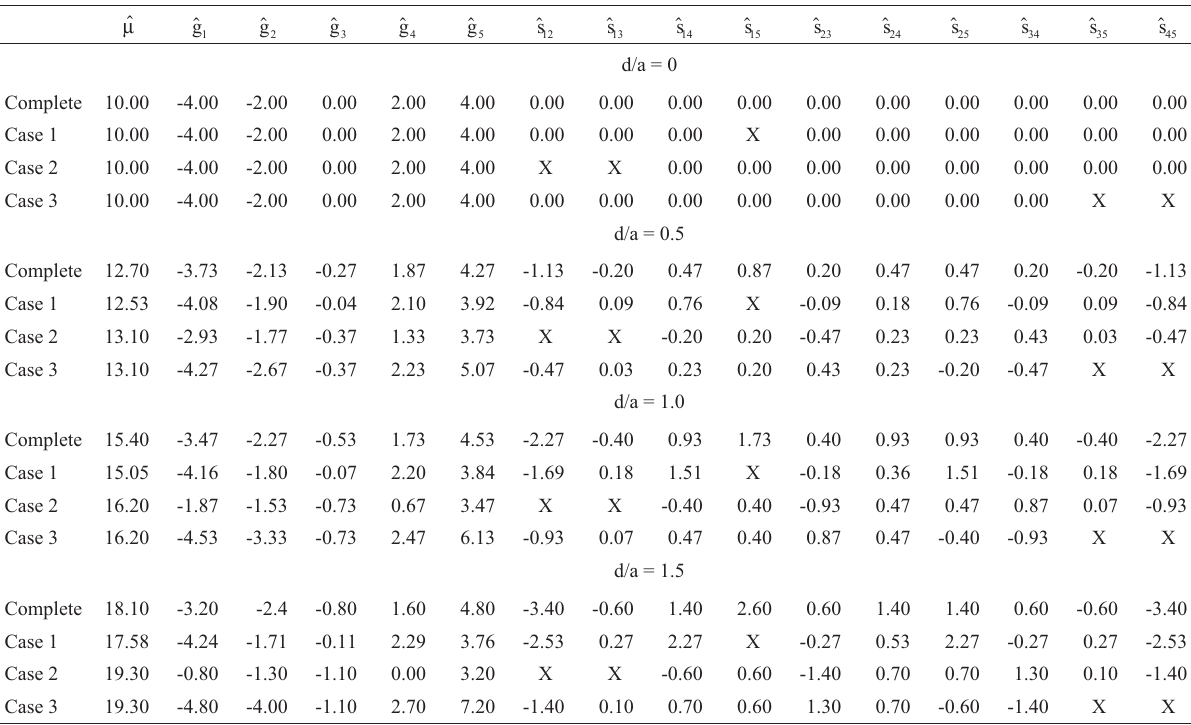
Table 6 - Estimates of the parameters of the complete and incomplete diallel models for Cases 1, 2 and 3